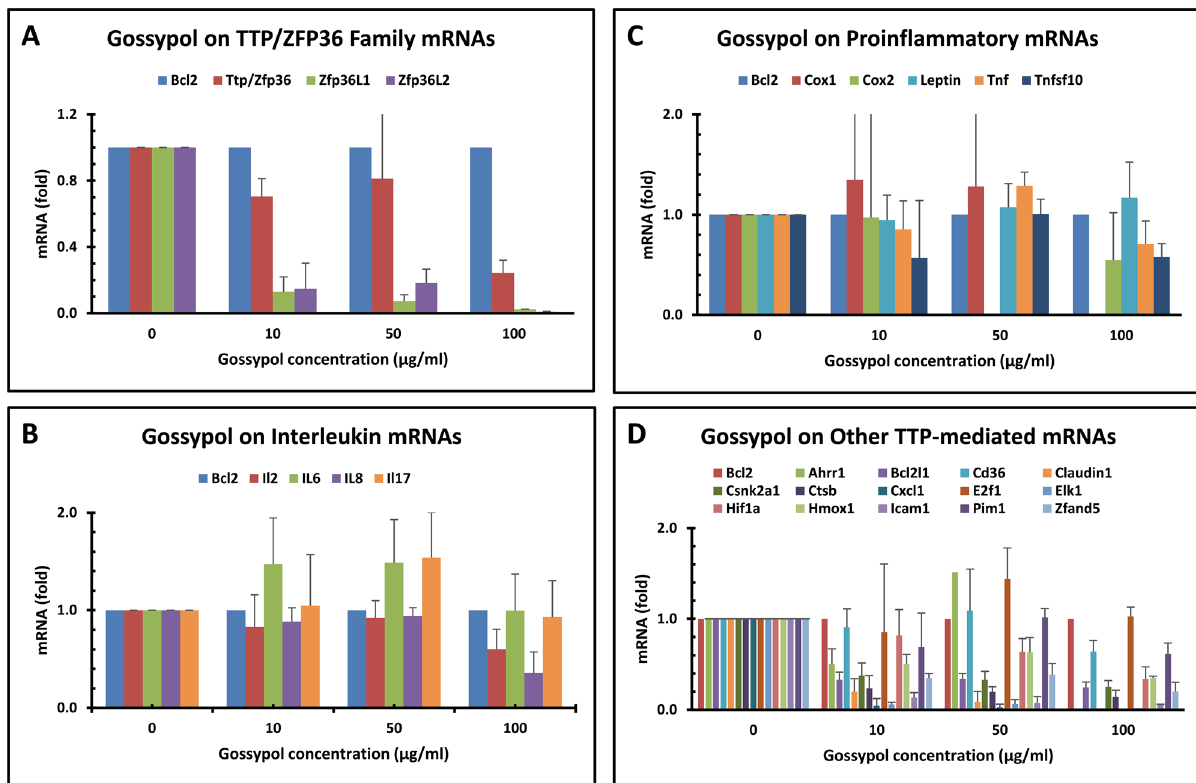
coded for TTP-mediated proinflammatory cytokine mRNAs. ( D ) genes coded for other TTP-mediated